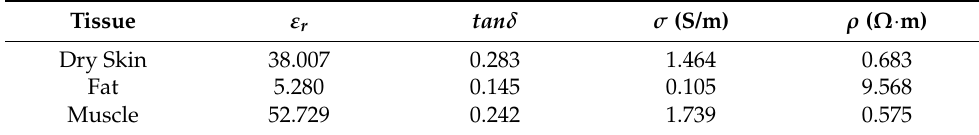
Table 4. Electromagnetic properties of human tissues tested at 2.45 GHz [61].